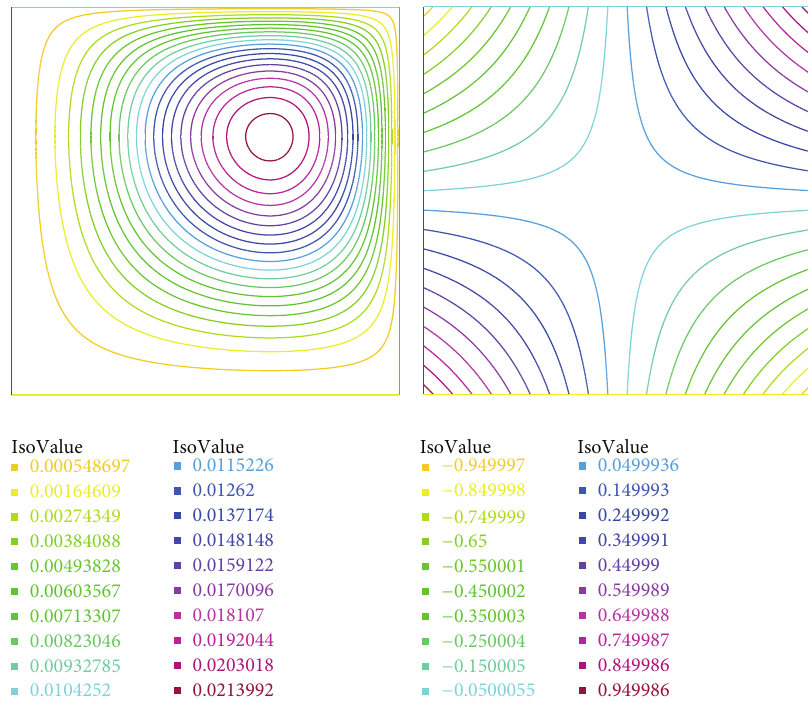
Figure 5: Streamline of flow and pressure contour by Newton